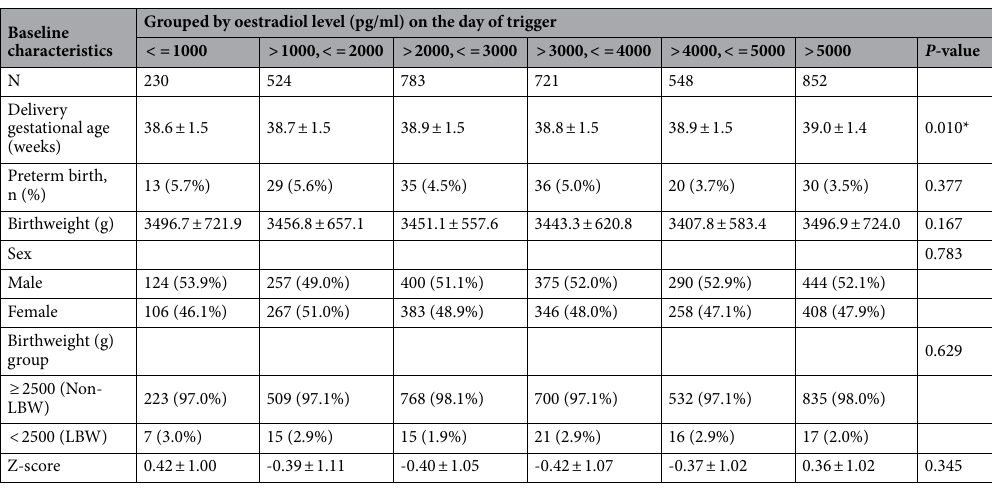
Table 3. Neonatal outcomes grouped by oestradiol level on trigger day. Data are presented as the mean ± SD or number (percentage). LBW: low birth weight. Non-LBW: non-low birth weight. P -values < 0.05 indicate significant differences and are bolded.